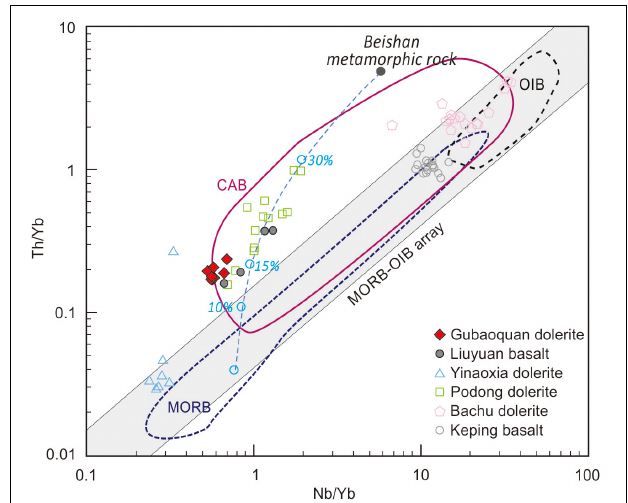
FIGURE 8 | Nb/Yb versus Th/Yb diagram for the dolerite dykes and basalts in Beishan area. MORB , Mid-ocean ridge basalt; OIB , Ocean island basalt; CAB , Continental arc basalt; MORB-OIB array is from Pearce (2008); The CAB, OIB, MORB fields are from Li et al. (2015); Date sources: Yinaoxia dykes (Zhang et al., 2015), Podong dykes (Xue et al., 2016), Tarim Bachu dolerite dykes (Yu, 2009), and Tarim Keping basalt (Jiang et al., 2004a), and Beishan metamorphic rock (Xie et al.,